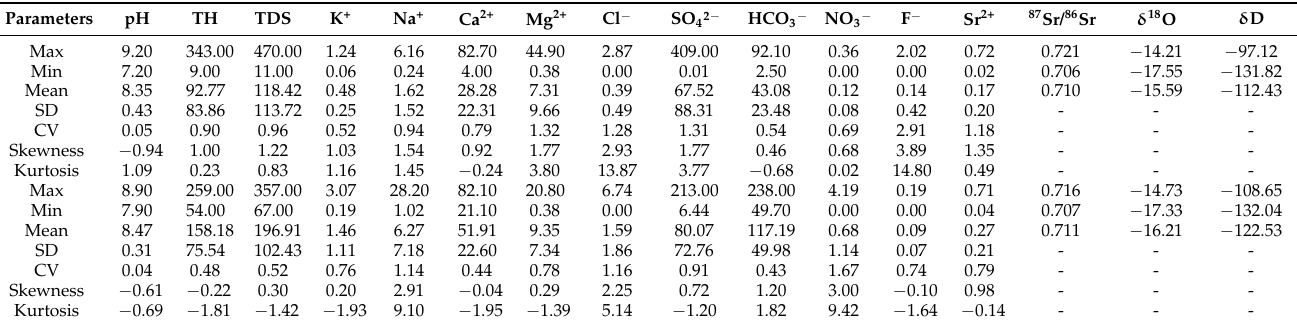
Table 1. Statistical analysis of chemical parameters of surface water and groundwater in the lower reaches of Yarlung Zangbo River.